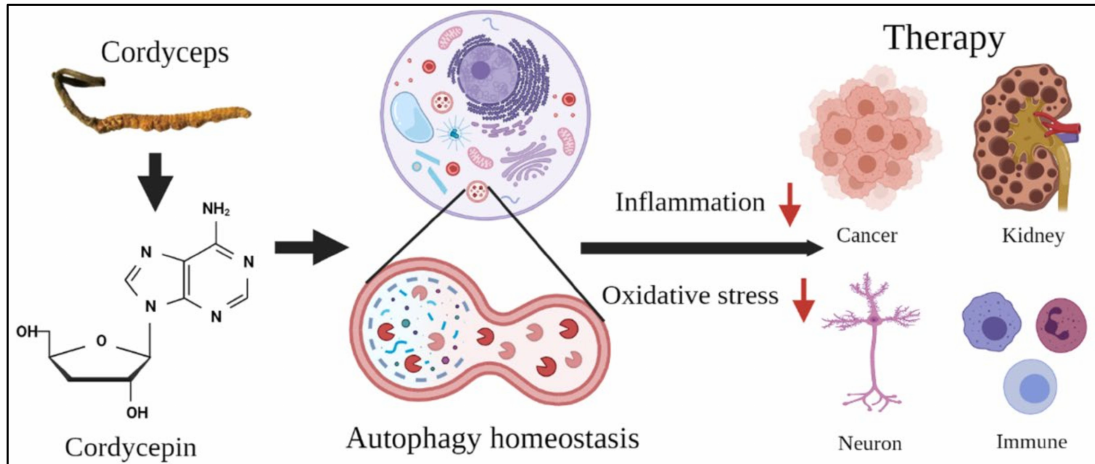
Figure 5. The possible potential therapy of cordycepin for different human diseases. The major extract cordycepin from Cordyceps regulates different stages of autophagy homeostasis inside cells to reduce inflammation and oxidative stress, providing further evidence of its potential as a candidate for therapy for cancer, kidney, neuron, and immune